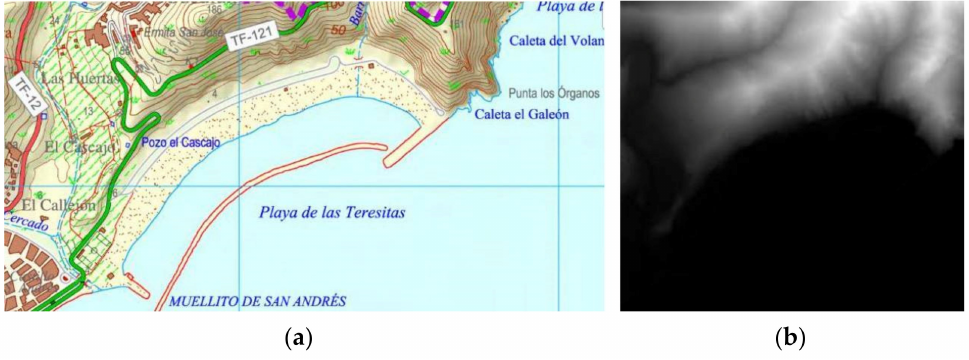
Figure 1. Original contour lines map of Las Teresitas beach ( a ) and height map ( b